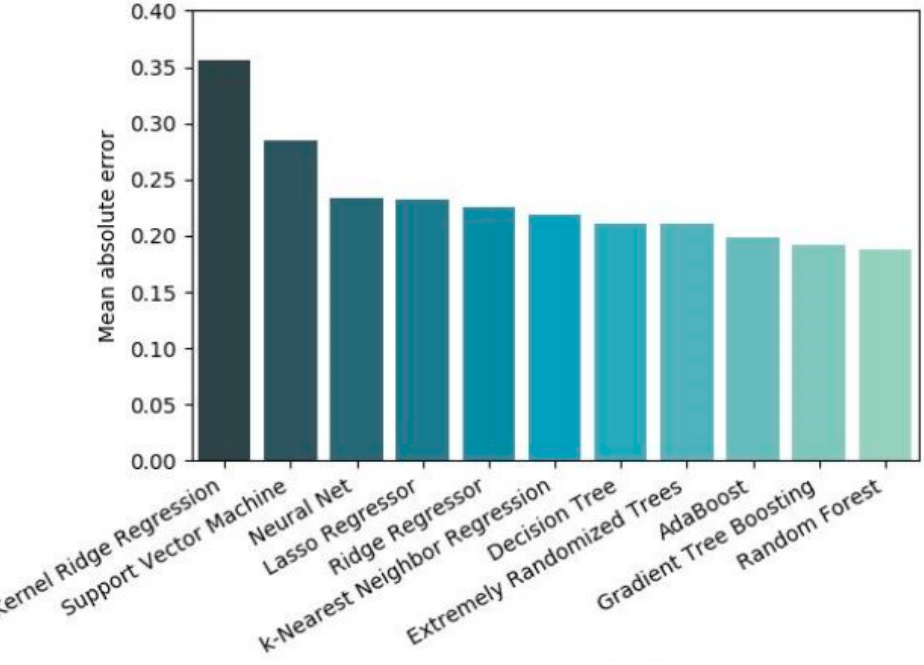
Figure 4. Machine learning algorithms performance comparison [7]. Reprinted with permission from Williams T. et al. (2020) Copyright 2020, American Chemical Society.